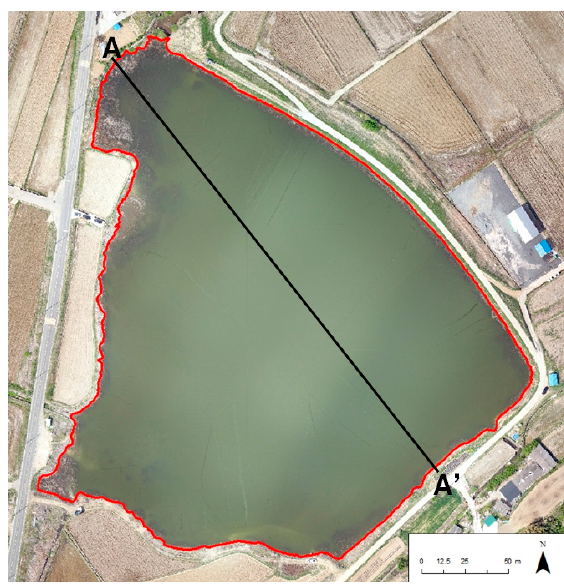
Figure 4. Section setting for the profile analysis.